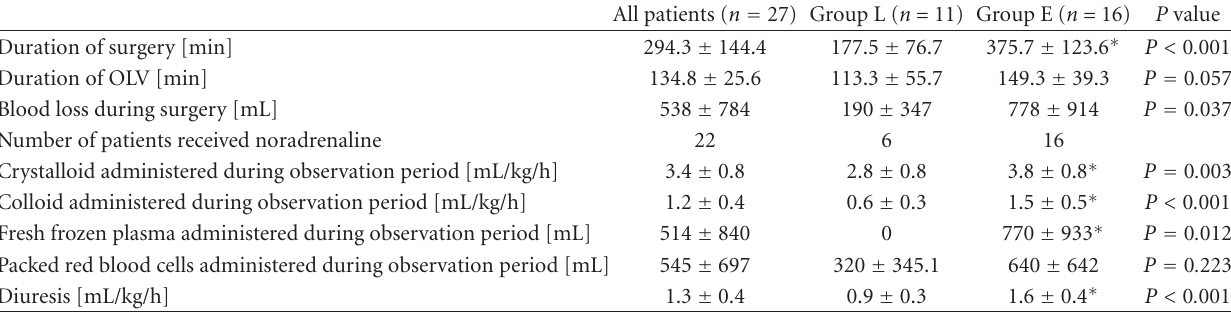
Table 2: Surgical data, fluid administration, and diuresis. ∗ Statistical significance between group L and group E analyzed by students t -test ( P < 0 .